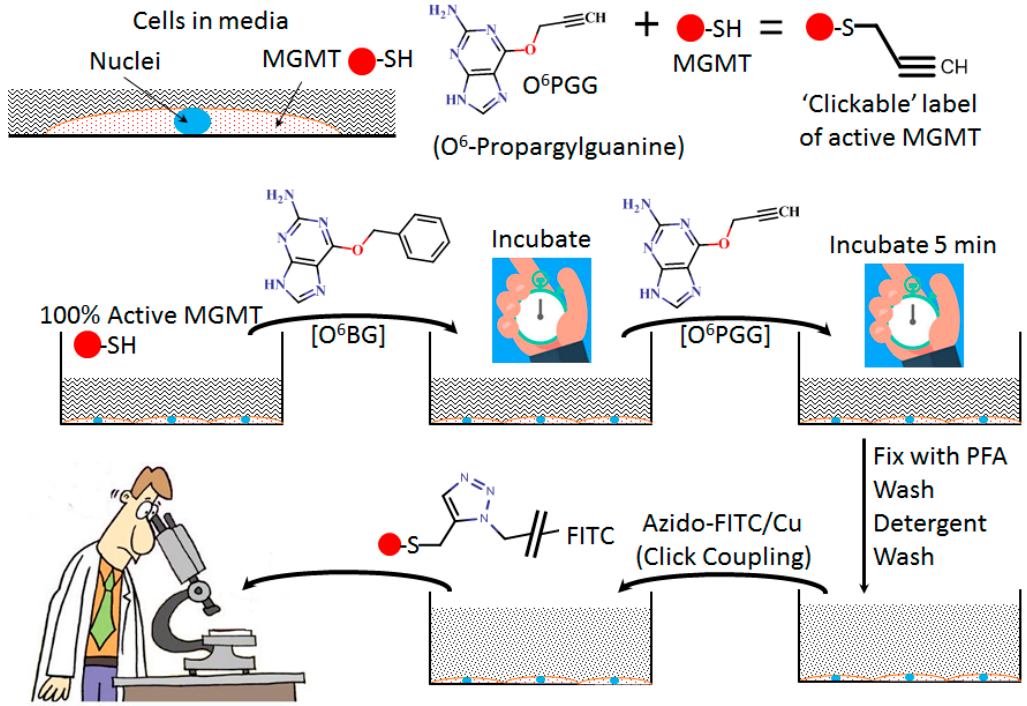
Figure 1. Cartoon depicting methodology used for the detection of active O 6 -methylguanine methyltransferase (MGMT) using O 6 PGG and Azido-PEG-FITC in glioblastomas (GBM).